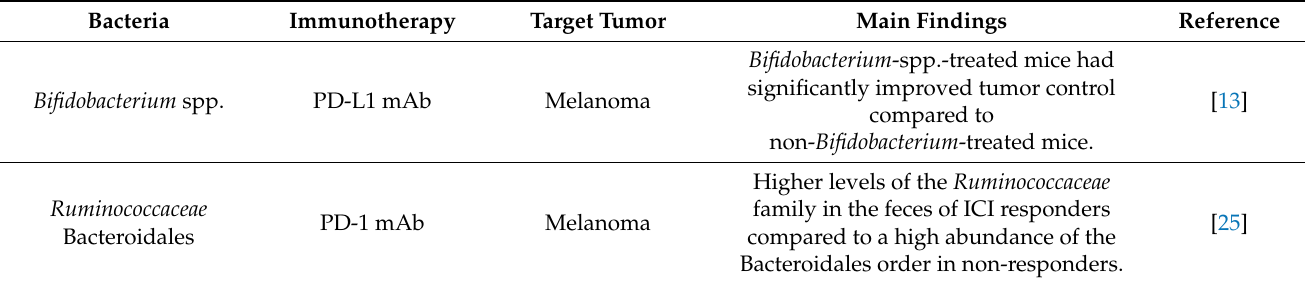
Bifidobacterium -spp.-treated mice had significantly improved tumor control compared to non- Bifidobacterium -treated mice.